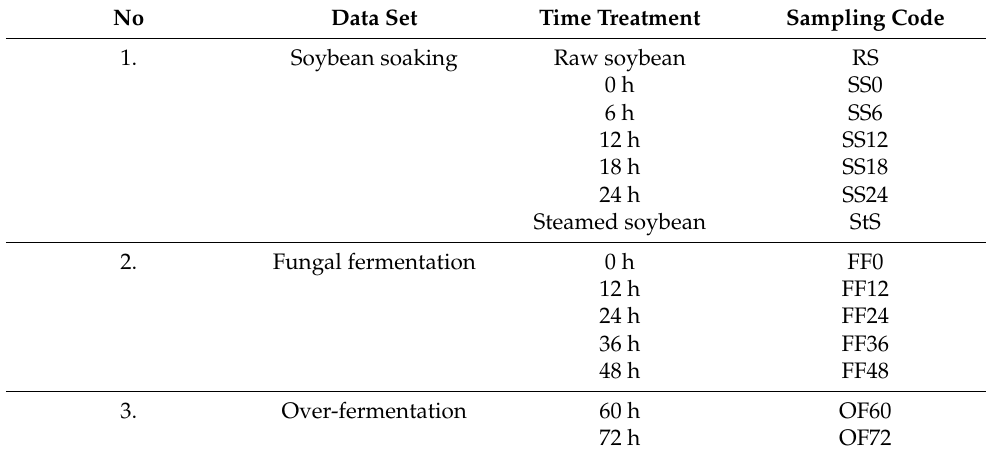
Table 1. Sample code list for tempe